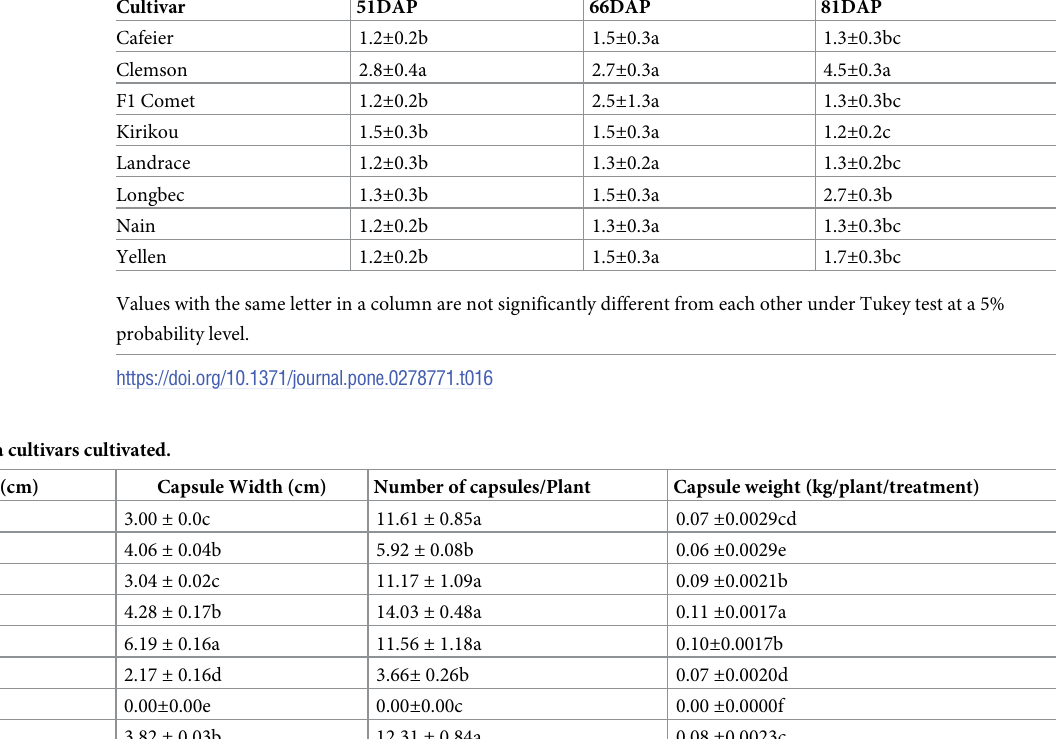
Table 16. Severity of mosaic disease on okra cultivars.